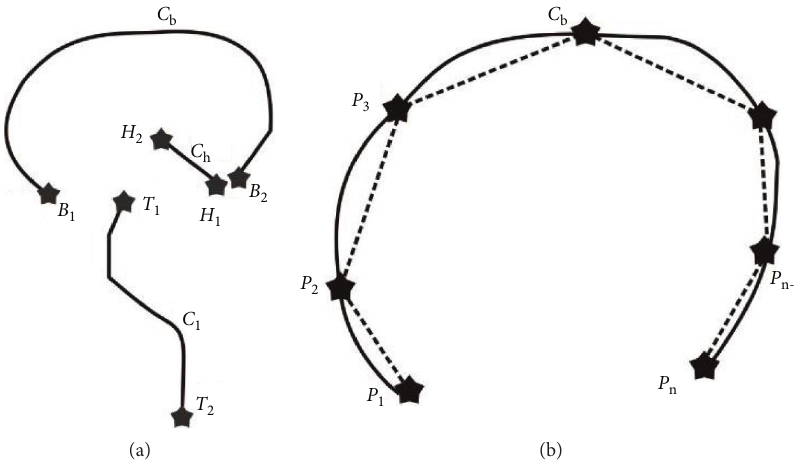
Figure 7: Sketch composition. (a) Sketch. (b) Generation line divis of cloud body.